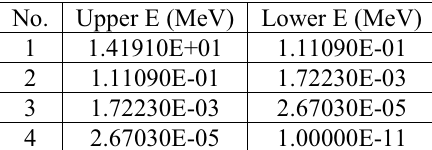
Table I. 4-group energy structure.